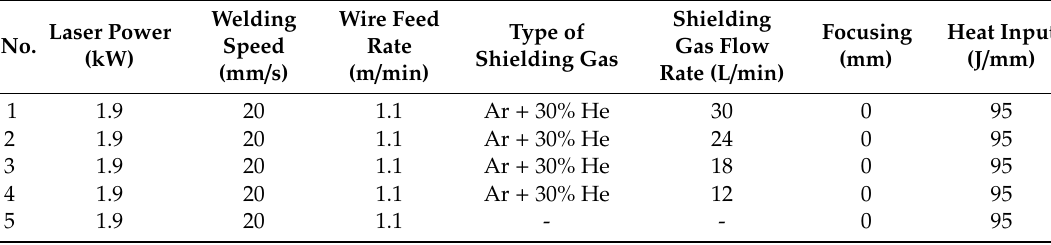
Table 4. Laser welding